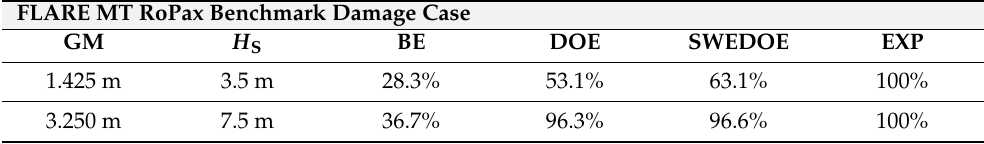
Table 2. Computed Times to Capsize TTC in percent in comparison with experimental values.